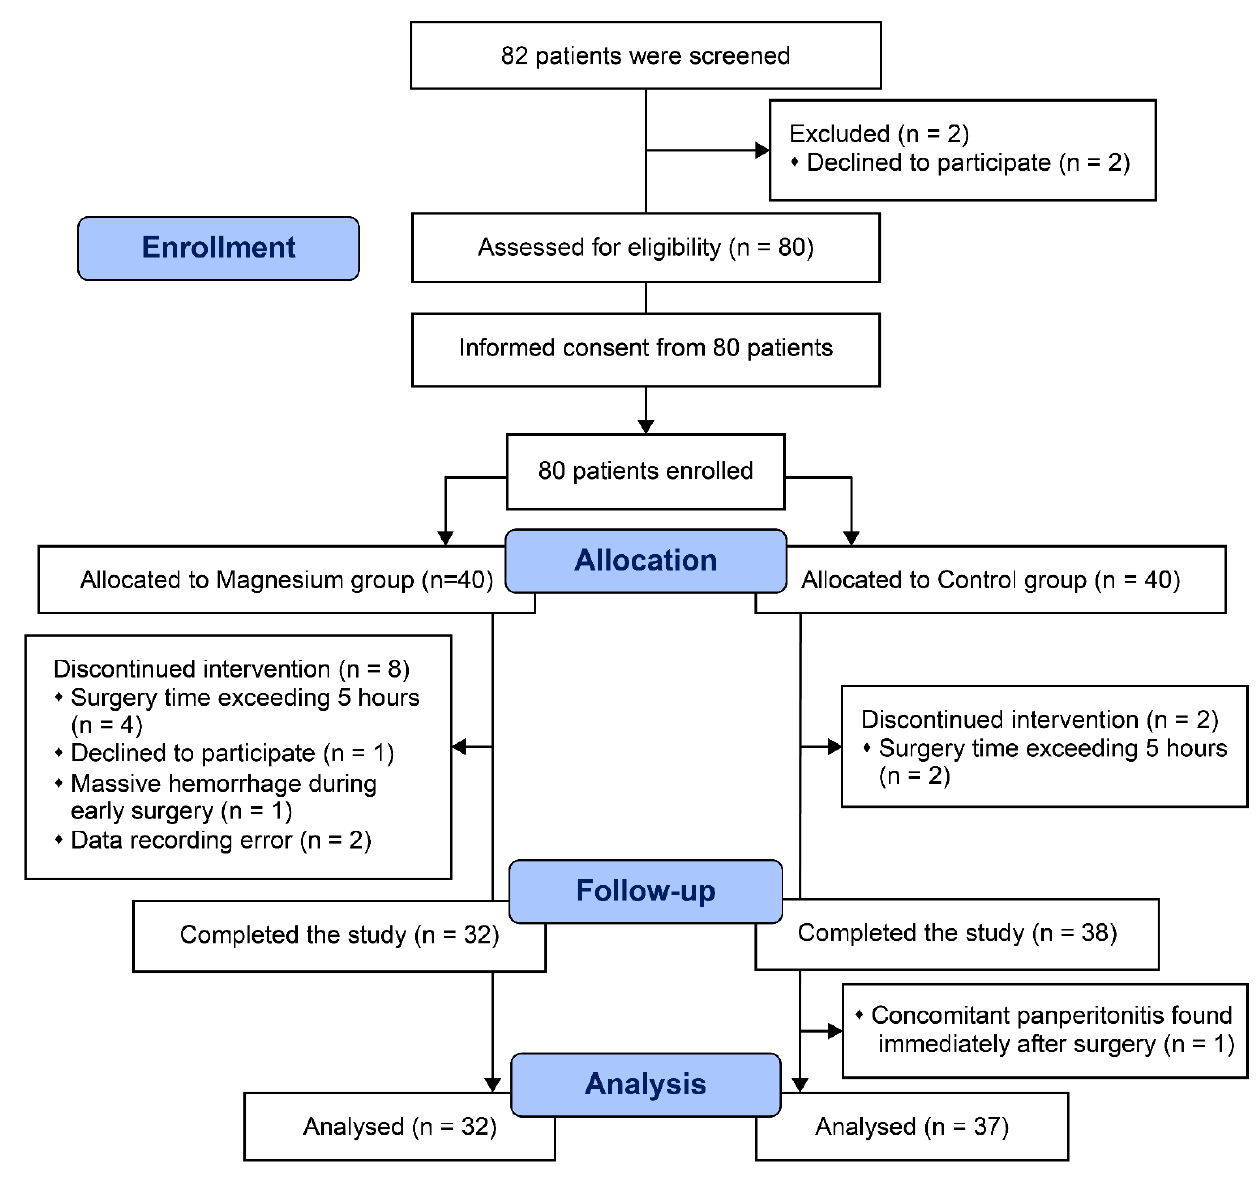
Figure 1. CONSORT diagram.